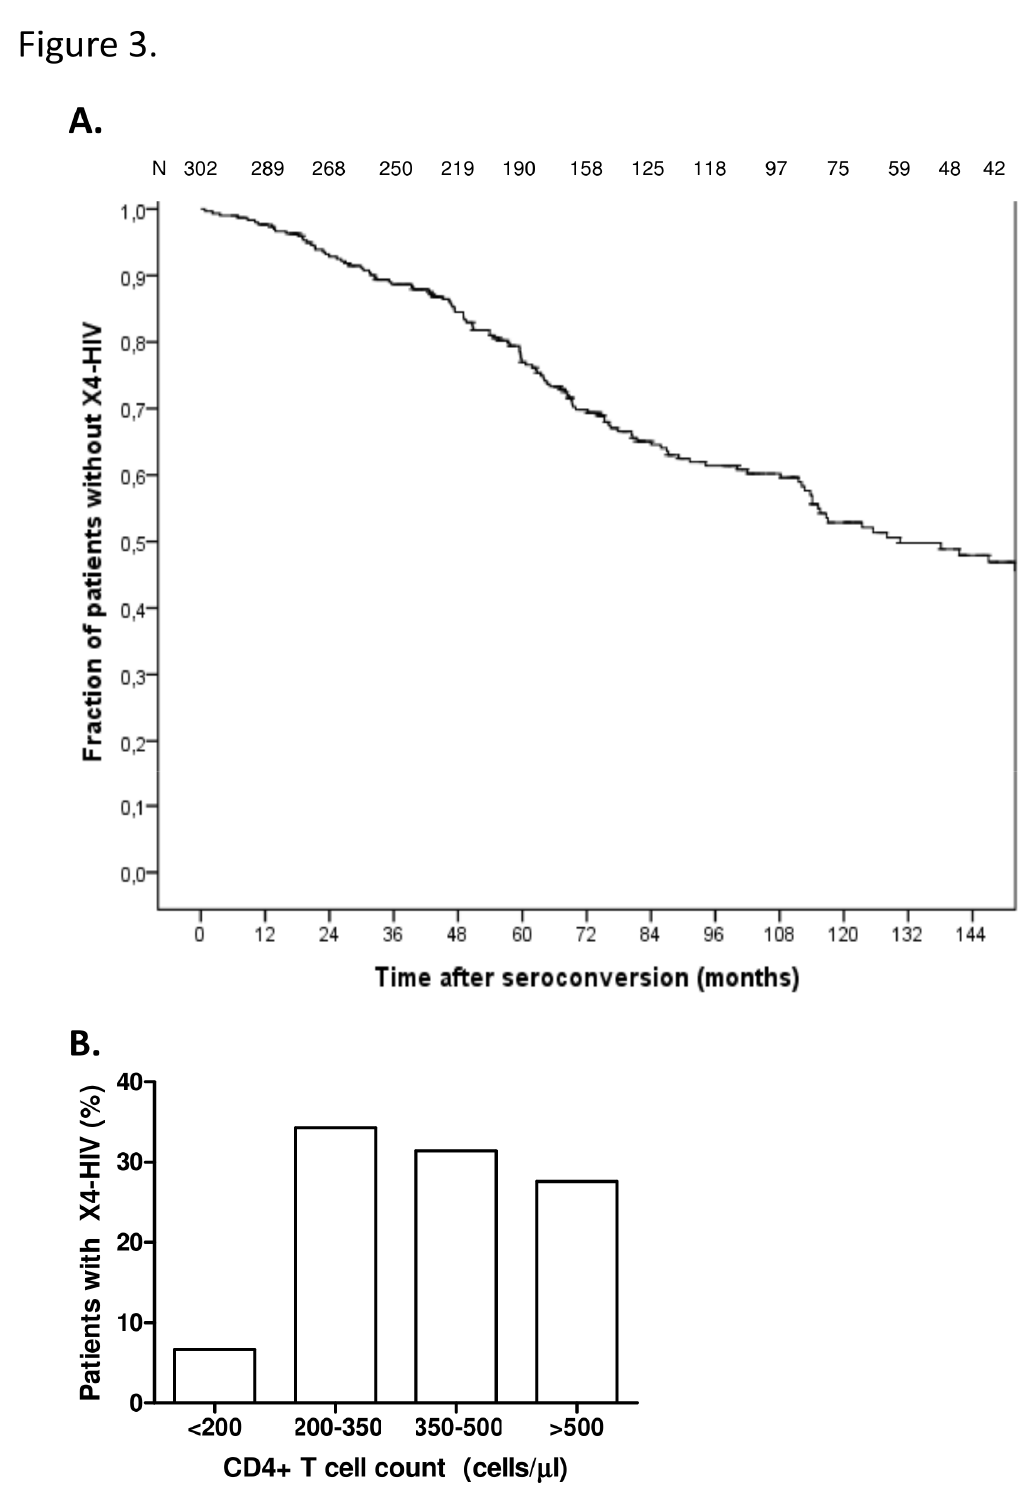
Figure 3. Emergence of X4-HIV variants in the ACS cohort. A. Cumulative fraction of patients harboring R5-HIV variants during HIV-1 infection. Numbers above the graph represent the number of patients in the analysis at that time. B. The percentage of patients that show X4-HIV emergence with absolute CD4+ T cell counts above below 200 cells/µl, between 200 and 350 cells/µl, between 350 and 500 cells/µl or above 500 cells/µl. doi: 10.1371/journal.pone.0076255.g003 PLOS ONE |